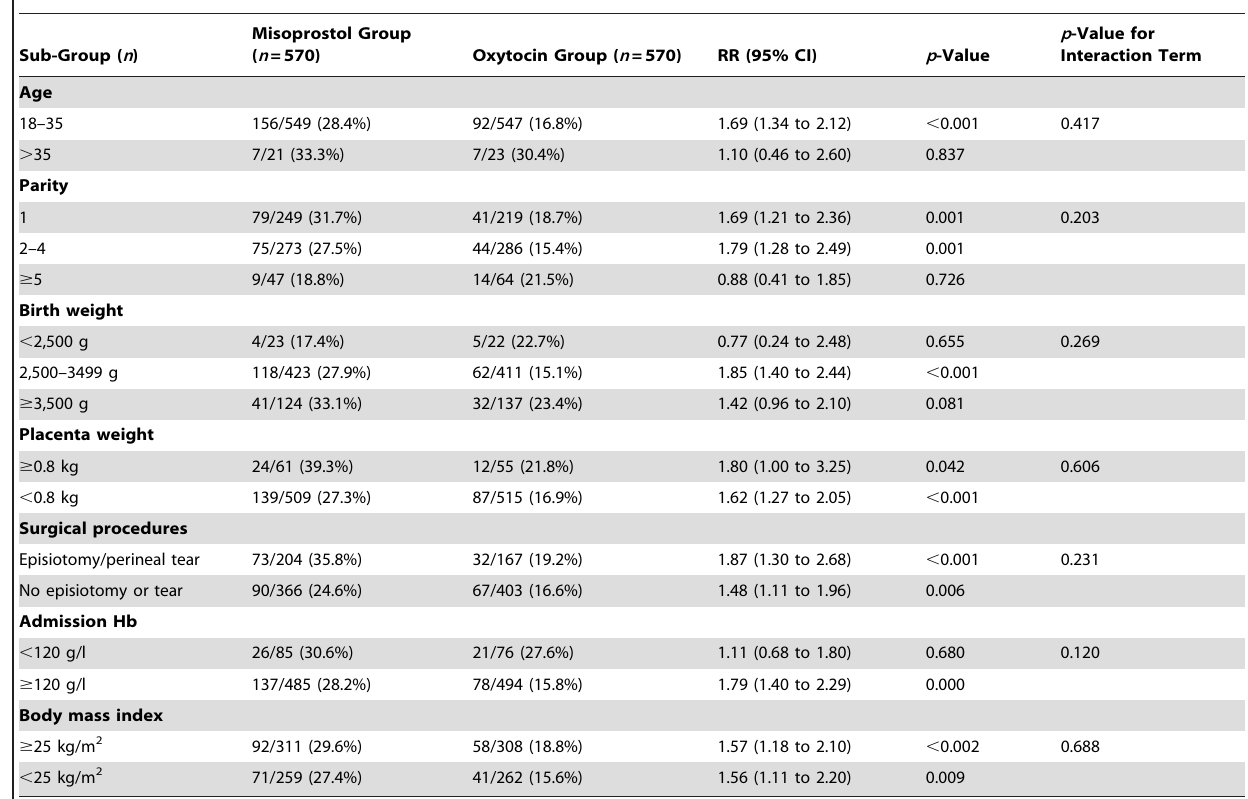
Table 3. Maternal baseline sub-groups by treatment group with